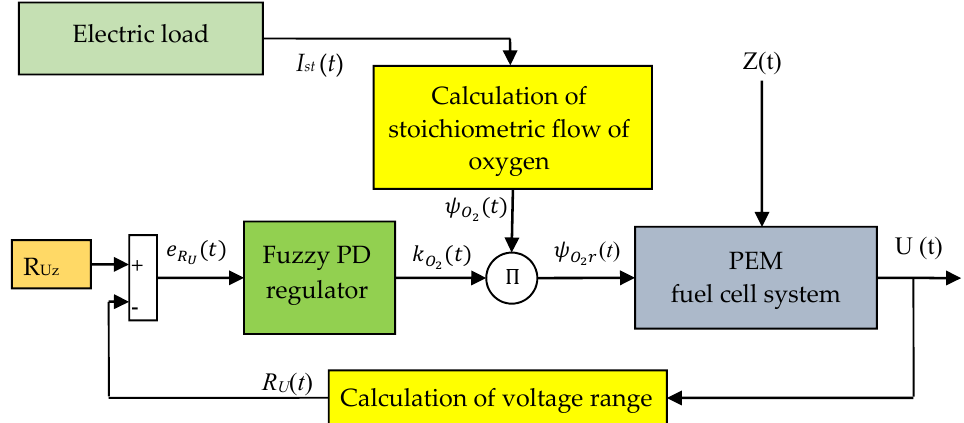
Figure 8. Diagram of fuzzy-based control algorithm of oxygen flow in PEM fuel cell stack.